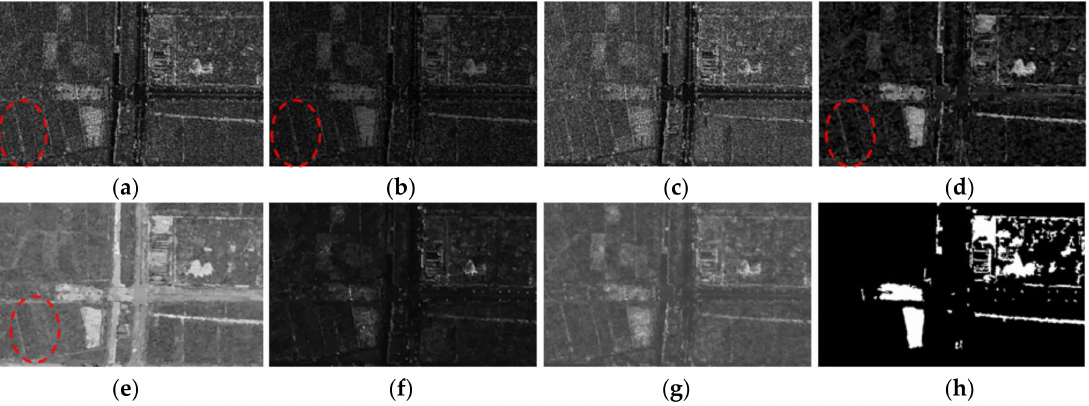
Figure 15. DIs of Beijing SAR data set generated by different methods: ( a ) LR; ( b ) MR; ( c ) DPCA;